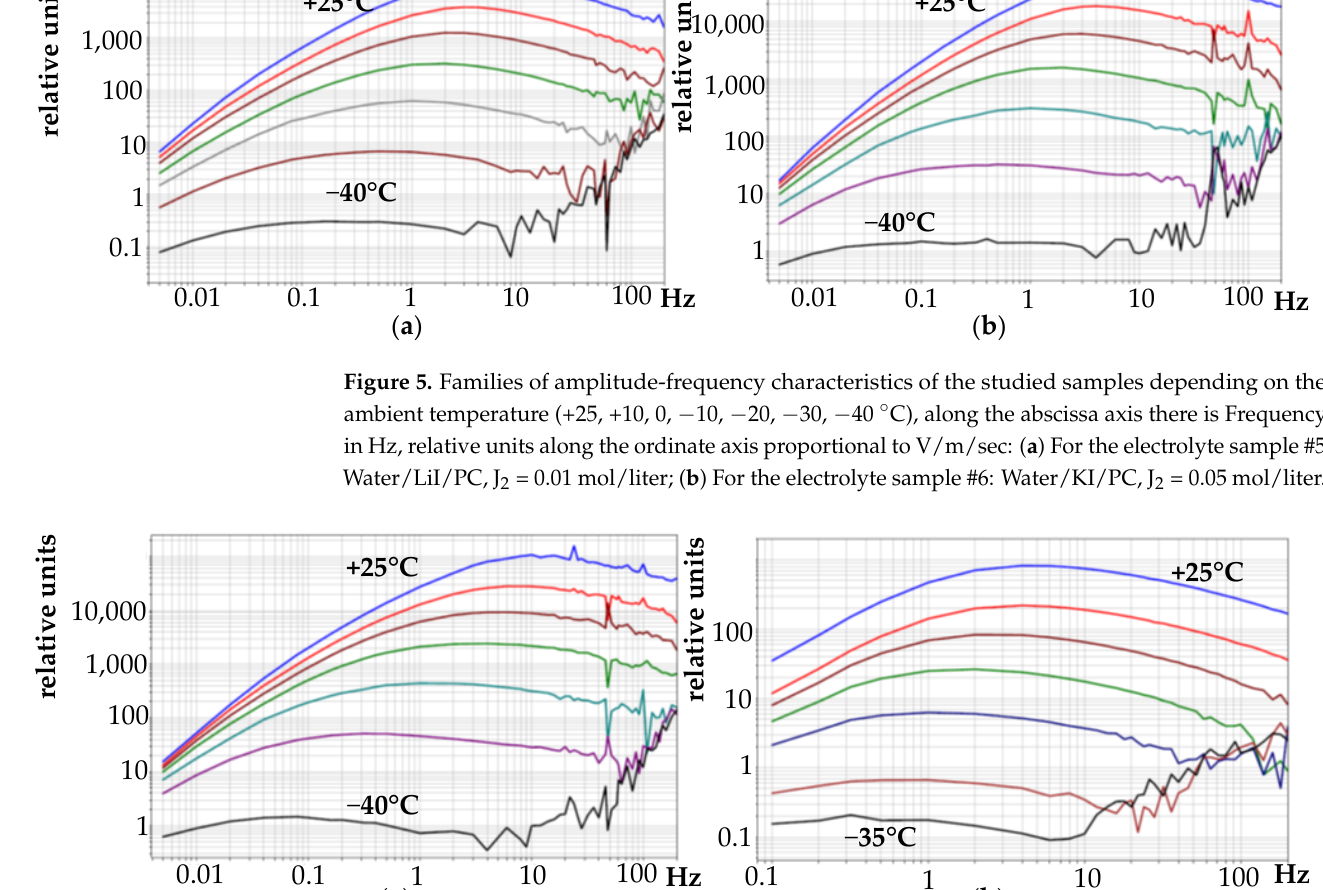
Figure 6. Families of amplitude-frequency characteristics of the studied samples depending on the